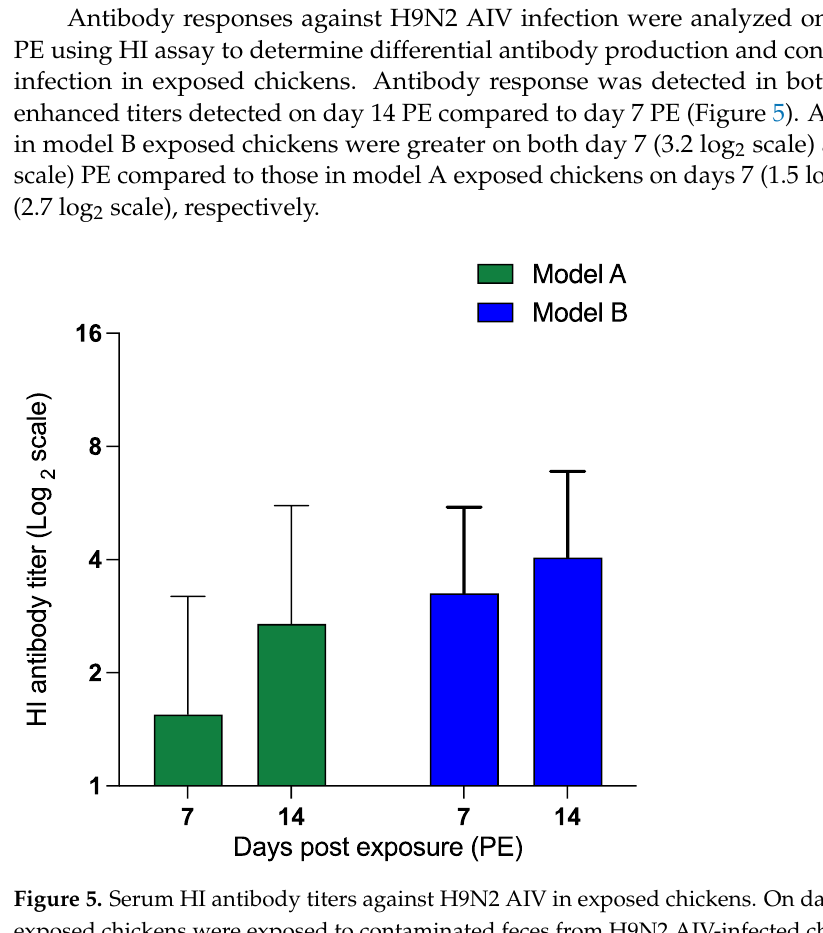
PE, post-exposure.